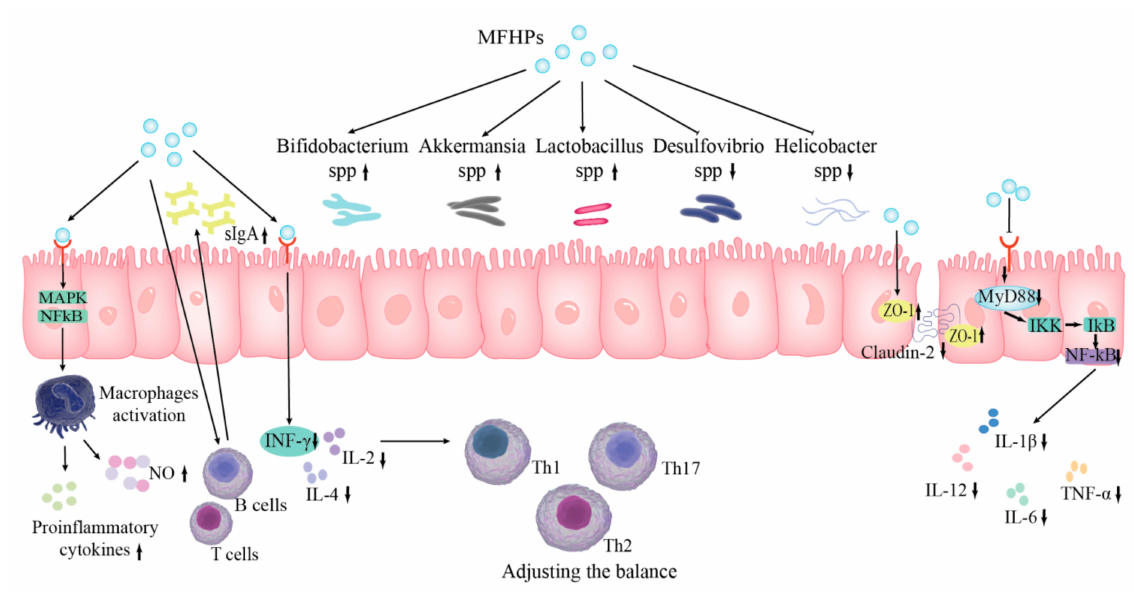
Figure 4. Intestinal barrier protection by